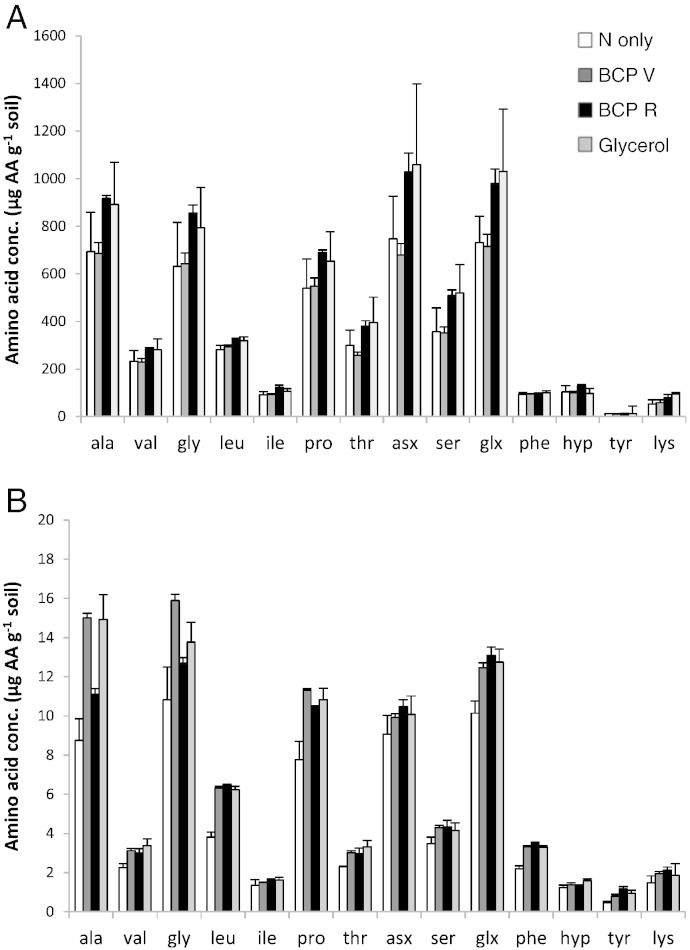
A: Total hydrolysable amino acids (THAAs), GC–FID quantified; data presented on the natural scale ± std. error; ANOVA of transformed data indicated no statistically significant treatment effect (p = 0.363).B: EPS amino acids, GC–FID quantified; data presented on the natural scale ± std. error; ANOVA of transformed data indicates treatment effects (Table 3; p = 0.024).